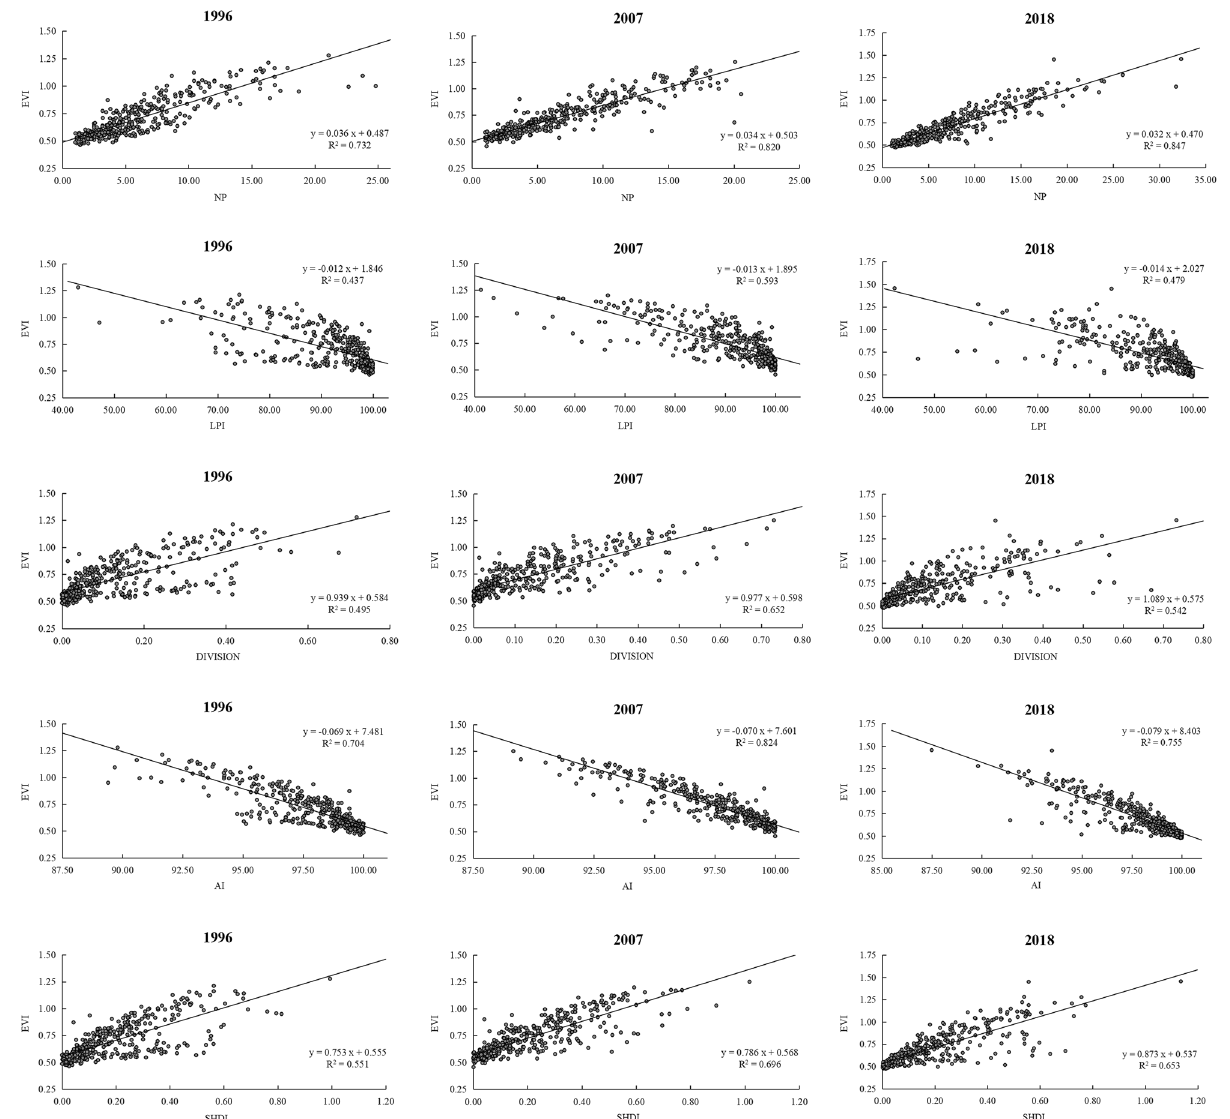
Figure 8. Scatter plot of linear regression of landscape pattern index and ecological vulnerability index. EVI, ecological vulnerability